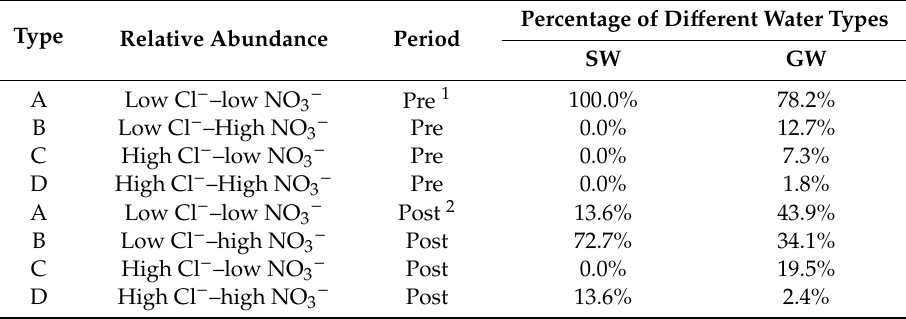
Figure 10. ( a ) Bivariate plot of Cl − vs. NO 3 − for distinguishing water types (points below 1 mg/L are not shown); dominant water types in each sampling site: ( b ) before the dam operation, ( c ) present status.